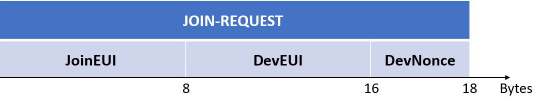
Figure 3. Join request message structure.